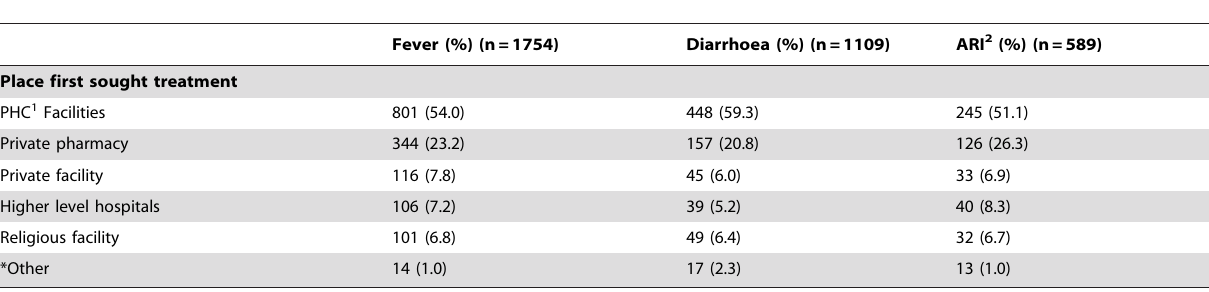
Table 2. First option of care attended for common childhood illnesses in Tanzania.